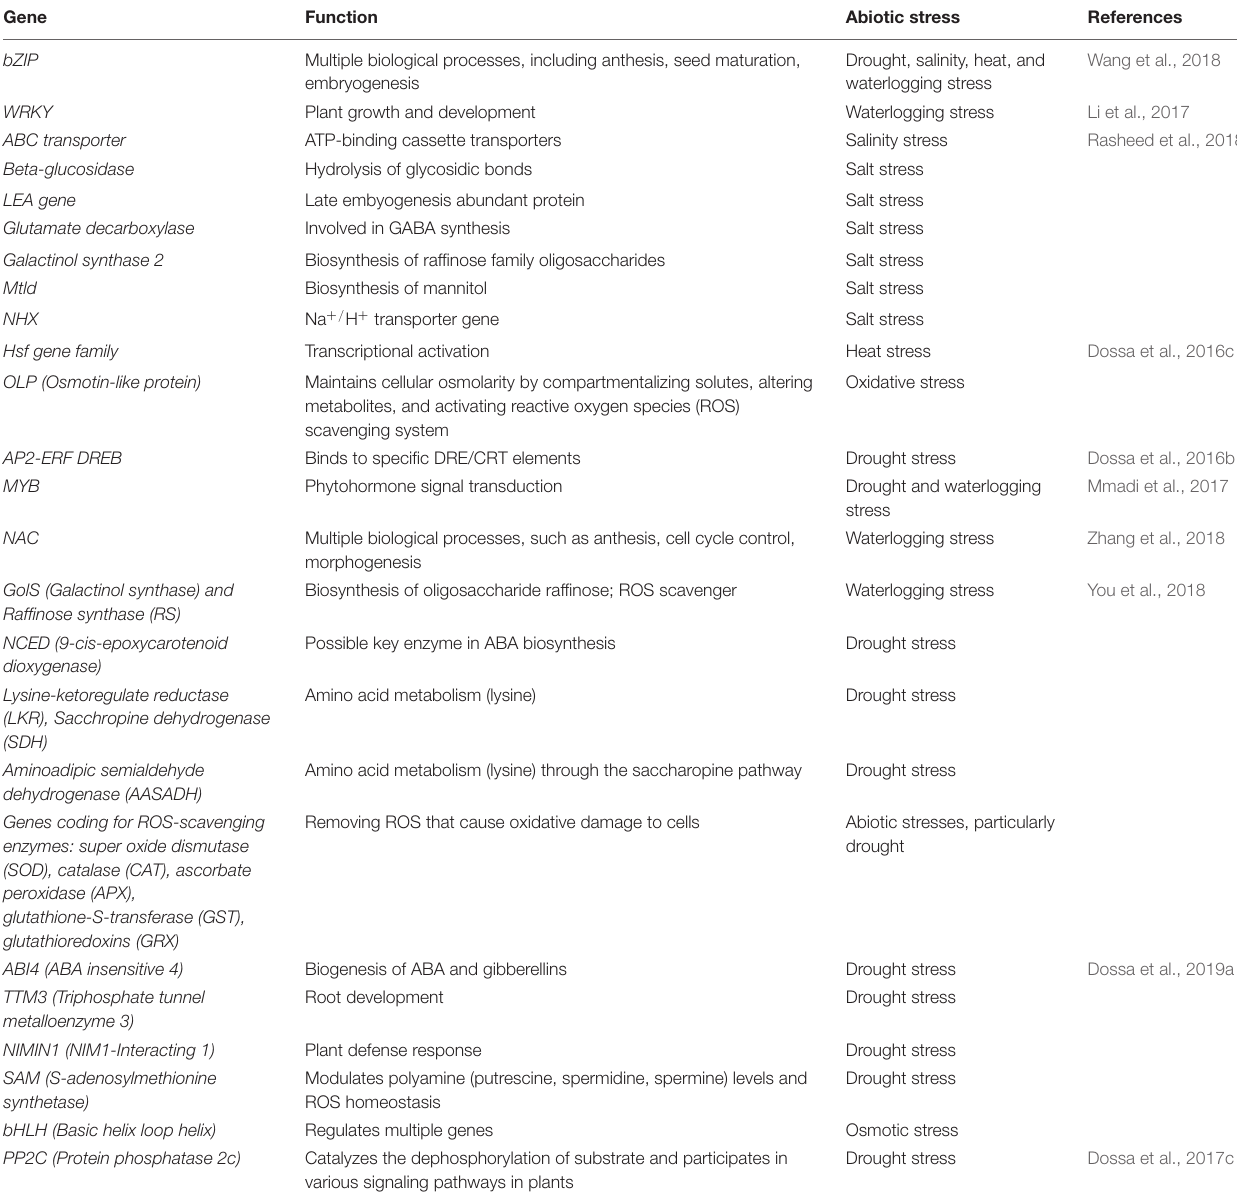
TABLE 6 | Genes for abiotic stress tolerance in